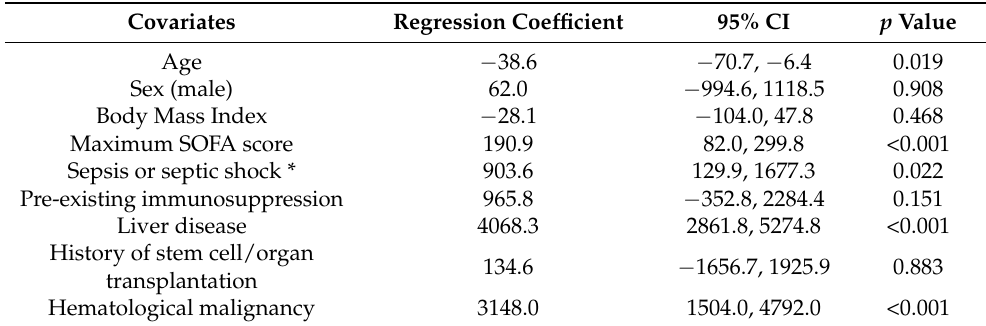
Table 2. Multivariable linear regression analysis for the influence of underlying diseases on maximum ferritin